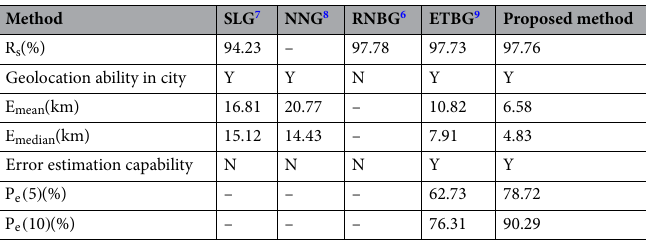
Table 6. Geolocation capability